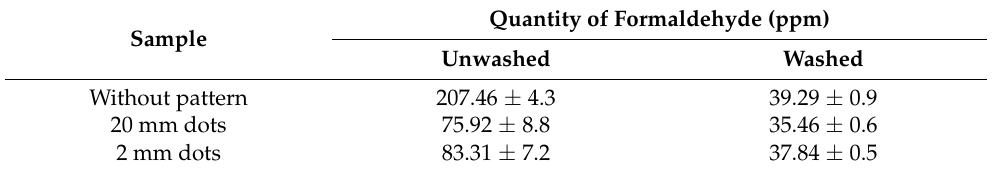
Table 5. Free formaldehyde quantity of fully printed samples and samples printed according to